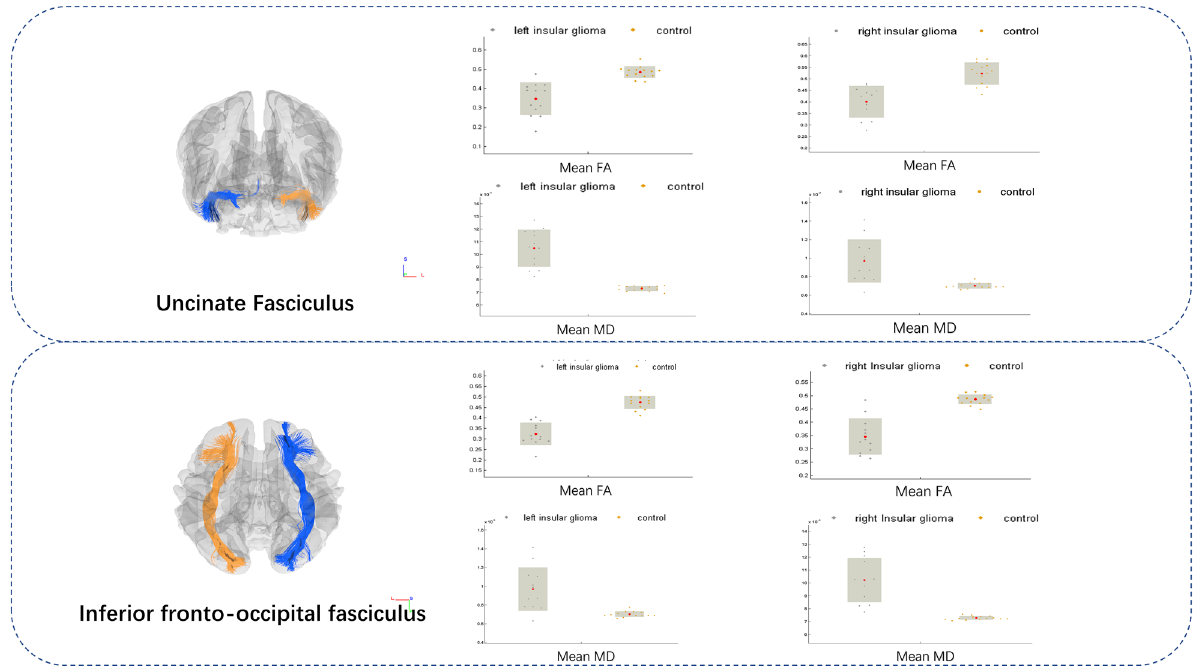
Figure 2. Atlas-based analysis showed significant MD increases and FA decreases at the IFOF and uncinate fasciculus in left- and right-sided glioma patients (two-samples t-test, FWE-corrected P < 0.05). A dot-bar figure of group values for MD and FA is shown. Gray dots represent the averaged values of patients, while orange dots represent those of controls. Left glioma Control Corrected P a